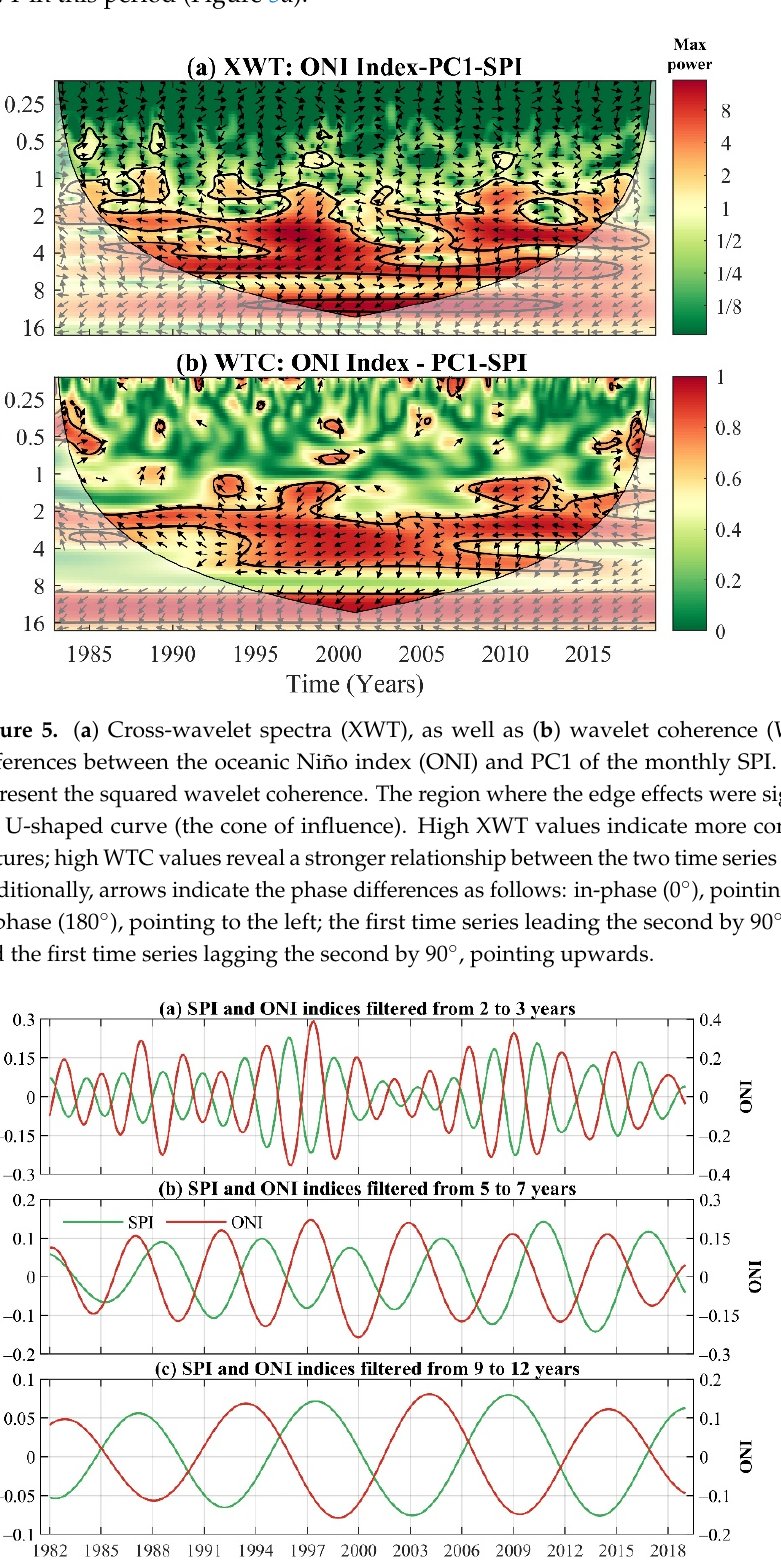
Figure 6. Filtered monthly SPI and ONI series for ( a ) 2–3 ‐ , ( b ) 5–7 ‐ , and ( c ) 9–12 ‐ year scales in the 1982–2019